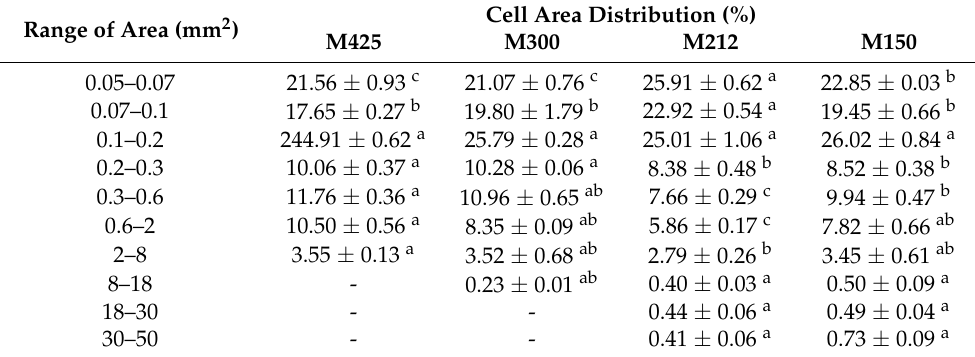
Table 4. Mean values and results of statistical analysis (one-way ANOVA followed by Tukey’s HSD test for multiple comparison) of cell area distribution, mean area, circularity and solidity of pores in the muffin